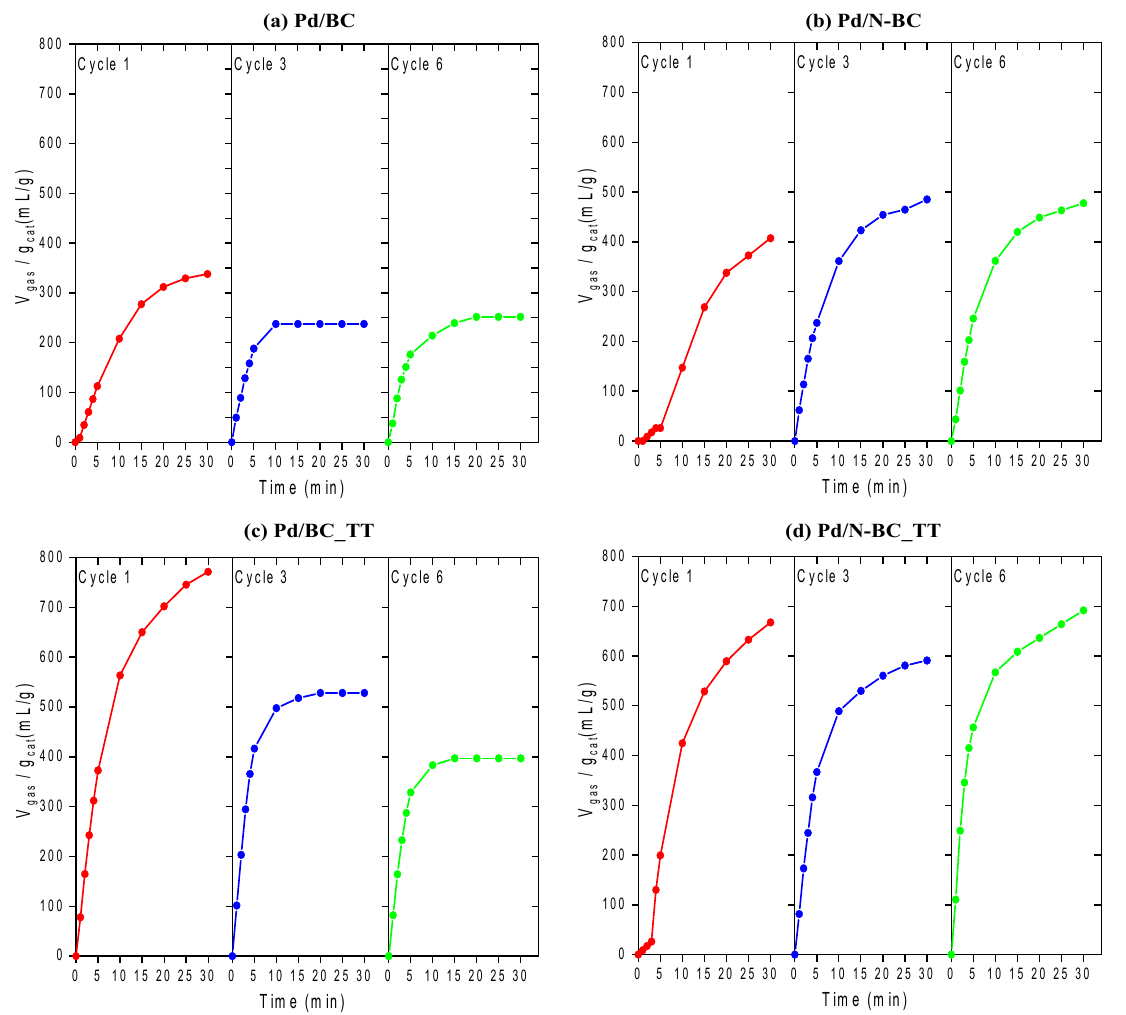
Figure 5. Gas evolution profiles (H 2 + CO 2 ) achieved for the 1st, 3rd, and 6th cycle for: ( a ) Pd/BC, ( b ) Pd/N-BC, ( c ) Pd/BC_TT, and ( d ) Pd/N-BC_TT.